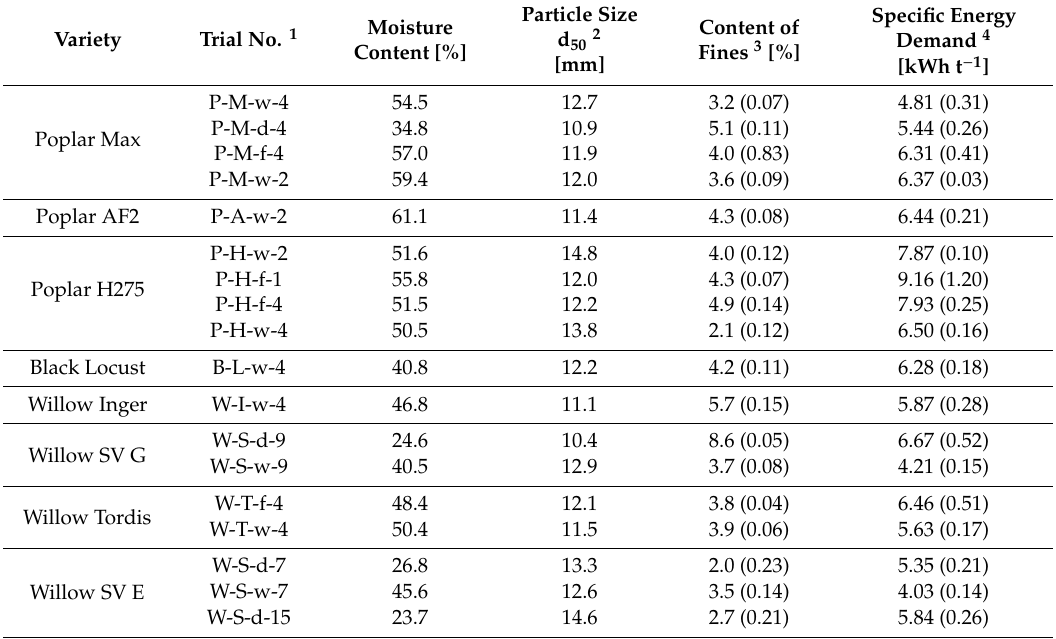
1 Labelling: Variety-Clone-Condition-No of shoots per trial. Example for labelling: W-S-d-15 = W illow, clone S alix viminalis , d ried shoots, 15 shoots per chipping trial. 2 Median value of the particle size distribution. 3